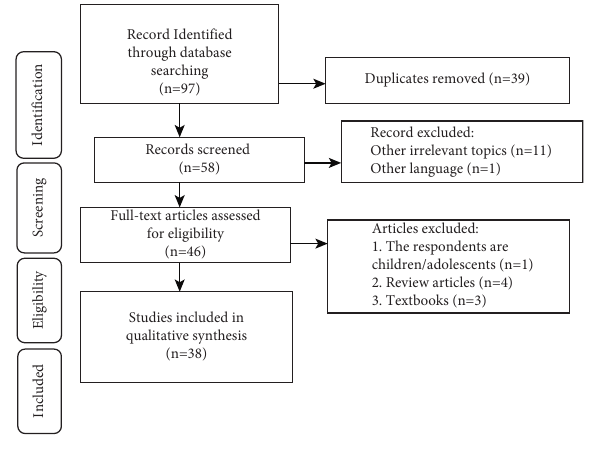
Figure 1: Study flow